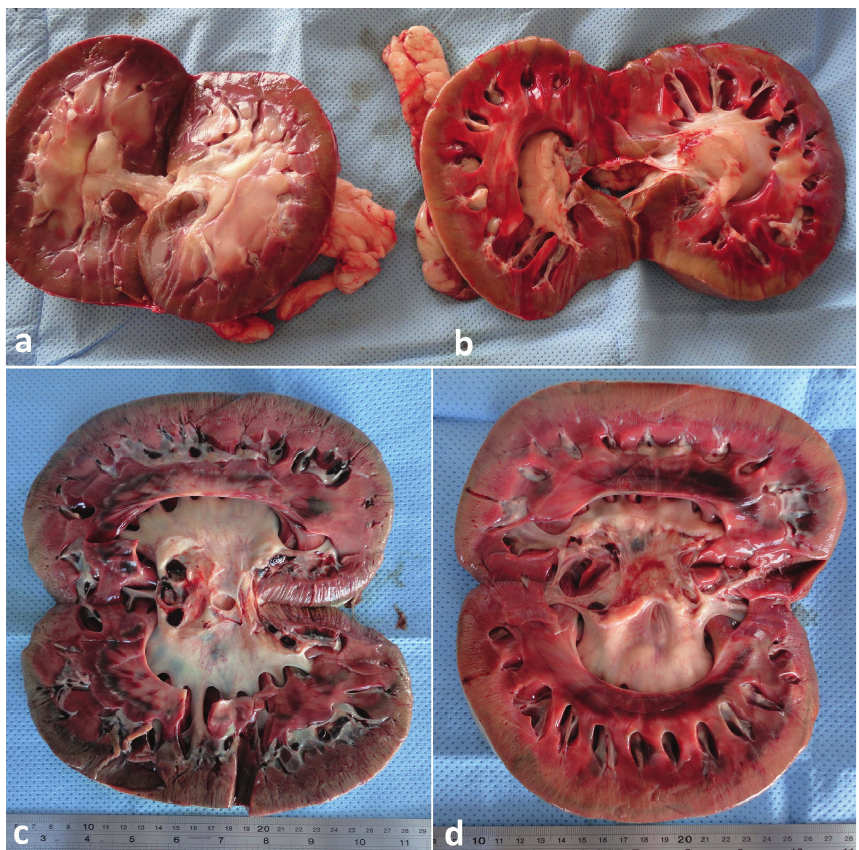
Figure 12: Unilateral hydronephrosis of the left kidney (b) in a female camel with pelvic abscessation detected postmortem compared to a healthy right kidney (a). Images (c) and (d) show bilateral hydronephrosis in a male camel with penile calculi.